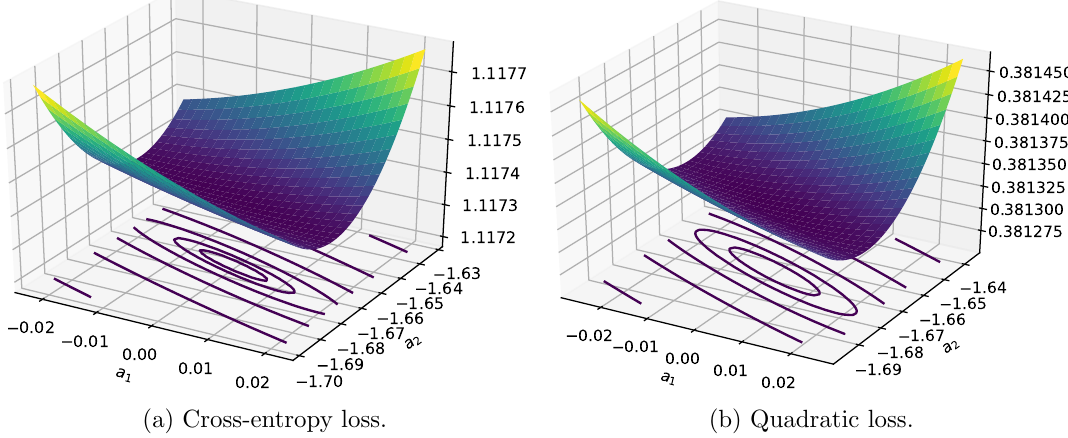
Figure 9 . Cost function as a function of a 1 and a 2 around the minimum point. b has been accordingly (cid:12)xed to the value in eq.